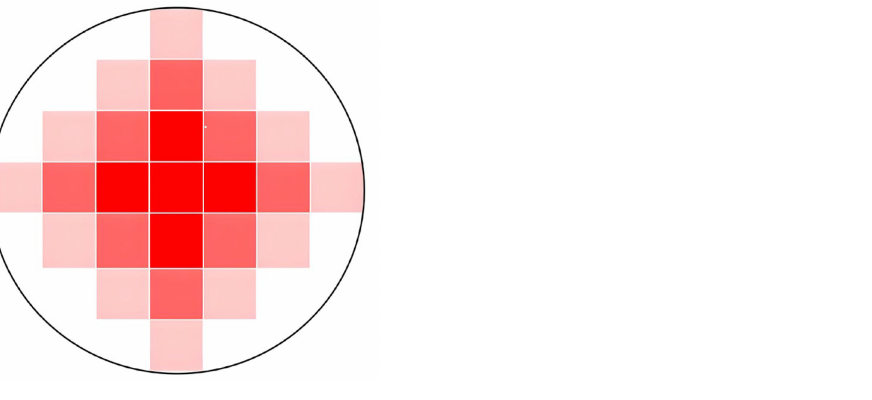
Figure 2. Distribution of two-dimensional grid. The darkest squares have Manhattan distance ≤ 1, the lightest squares have Manhattan distance = 3, and the squares in between have Manhattan distance =